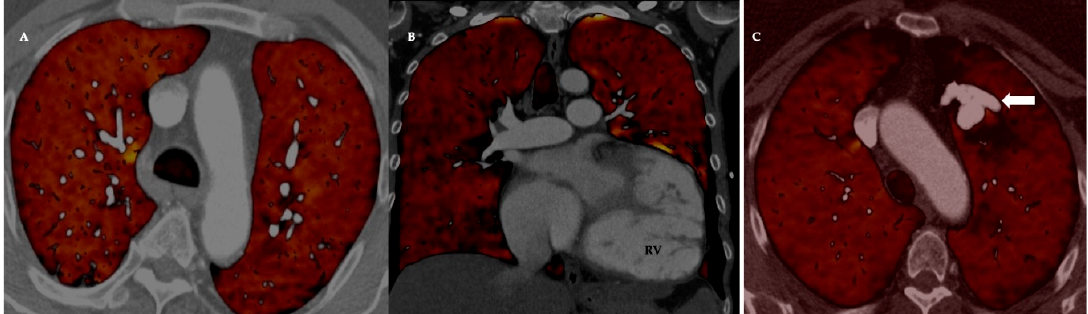
Figure 5. Dual-energy CT pulmonary angiography with normal perfusion (Panel A ), heterogenous mottled perfusion in pulmonary arterial hypertension (Panel B ), and regional reduction in perfusion around a pulmonary arteriovenous malformation (Block arrow, Panel C ). Note the dilated and hypertrophied right ventricle (RV) in the middle panel.